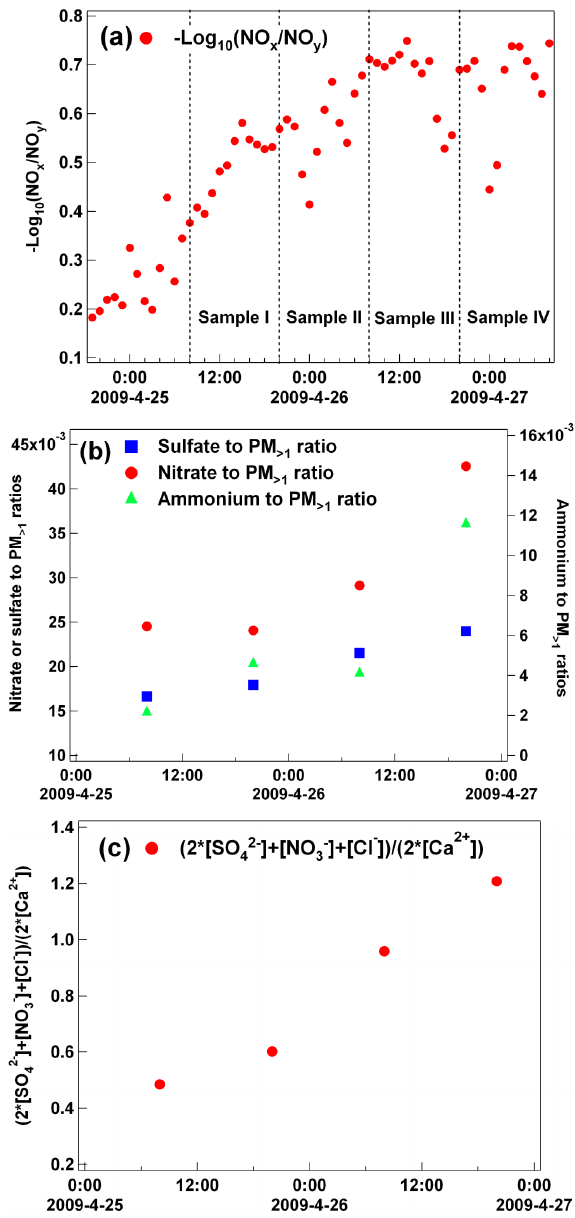
Fig. 5. (a) Photochemical age (defined as − Log 10 (NO x /NO y )) , (b) concentration ratios of sulfate, nitrate and ammonium to PM in the supermicron particles, (c) sum of major anions to calcium in equivalence in the supermicron particles, during the dust event on 24–26 April at Mt. Heng.